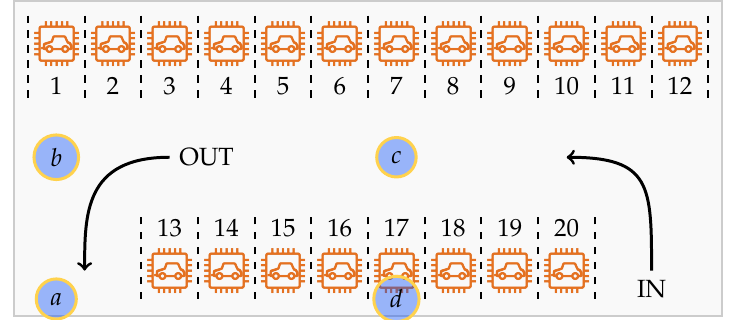
Figure 13. Edge gateway placement suitability in a parking slot during experiment. Gateway placement options are marked with a–d , and parking slots are marked with numbers 1–20.